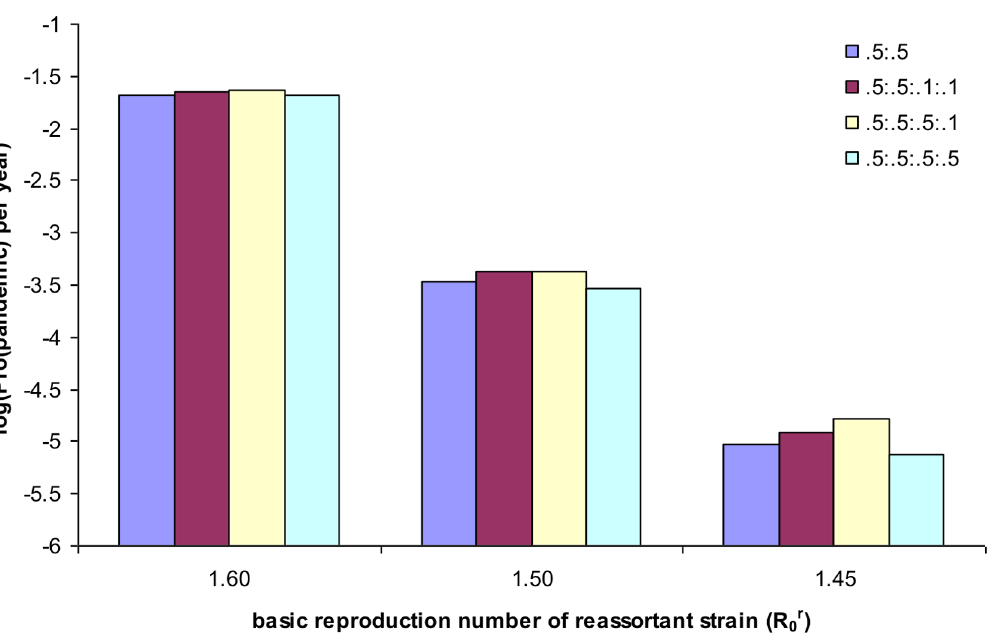
Fig. 2. Impact of transmissibility of the oncoming reassortant strain and cross-immunity induced by seasonal flu vaccination on the annual emergence probability of pandemic strain via reassortment. The duration of both infection and vaccination-induced immunity is two years and the values of other model parameters are as in Table 1. Here we consider a situation of cross-immunity structure where the cross-immunity conferred by vaccination are less than or equal to that by natural infection: Q : y : Q V : y V 5 0.5:0.5:0.1:0.1 (red), and 0.5:0.5:0.5:0.1 (yellow), 0.5:0.5:0.5:0.5 (green). For comparison, the situations without vaccination (blue) are also shown. As the basic reproduction number ( R 0r ) of reassortant strain reduces, the emergence probability of pandemic decreases rapidly. For example, when R 0r decreases to 1.4, the annual probability of pandemic emergence reduces to below 10 2 6 (data not shown).